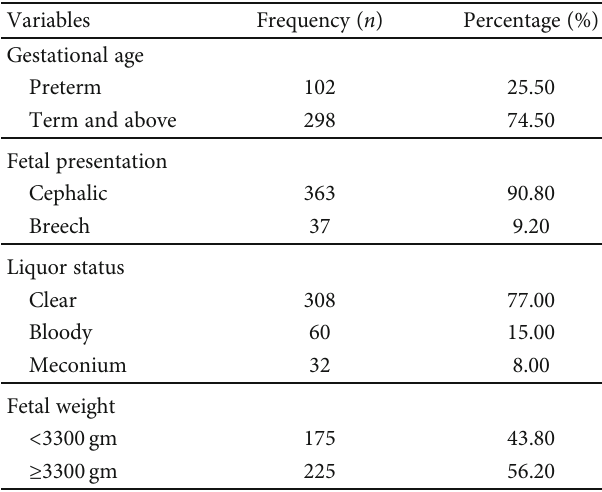
Table 2: Labor- and delivery-related characteristics of the study on magnitude and associated factors of episiotomy in Arba Minch General Hospital, Southern Ethiopia, 2019.